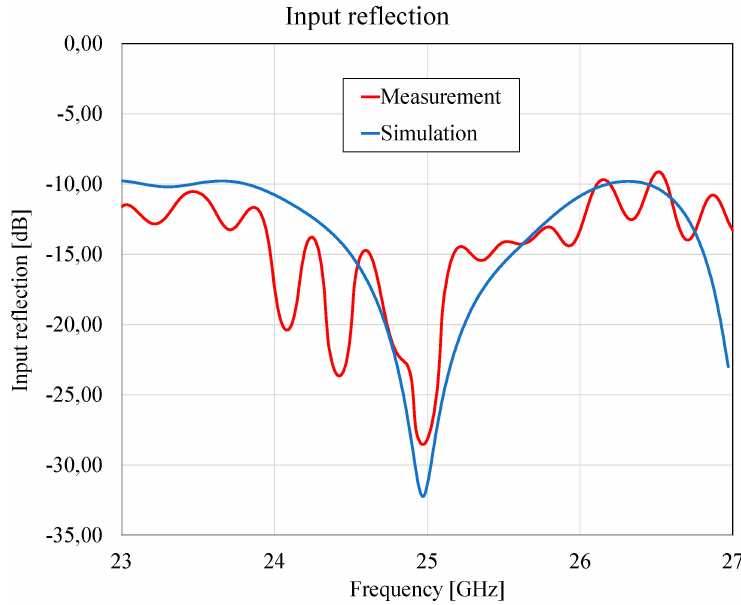
Figure 25. Microstrip antenna input reflection.